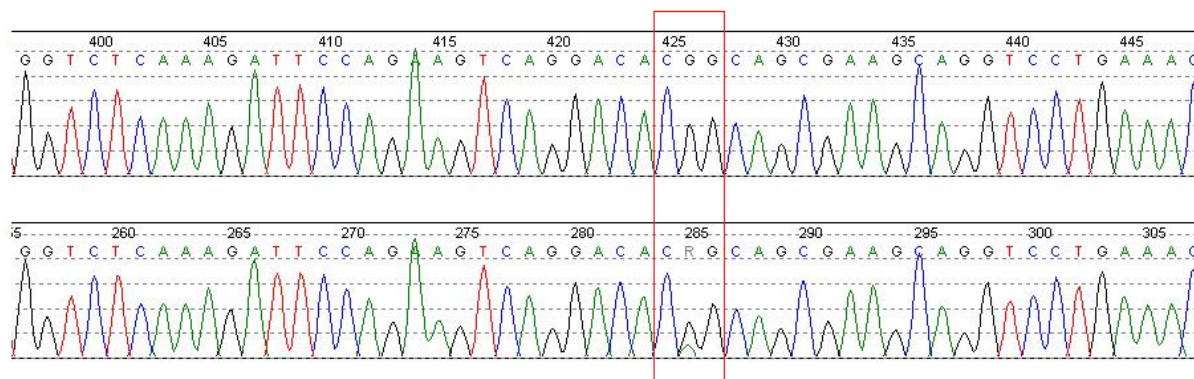
Fig. 5. Part of the GNAS gene sequence – reference sequence NM_000516 (upper row), patient sequence with the c.601C>T/p. R201C mutation (lower row). The red square is a